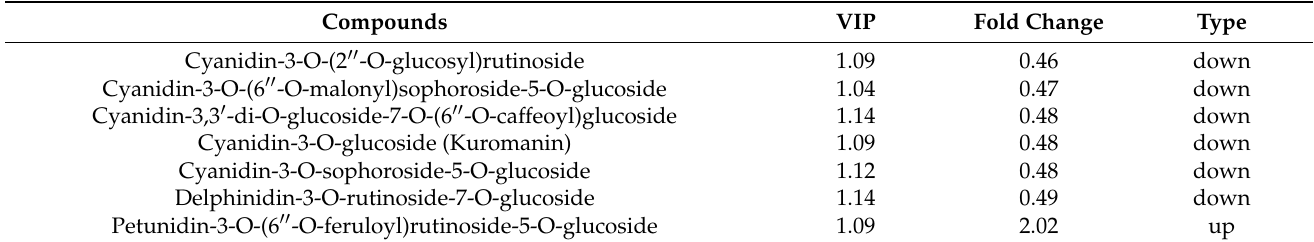
Table 2. Seven anthocyanins changed significantly in PhSK -silenced and control petunia corollas. Compounds VIP Fold Change Type Cyanidin-3-O-(2 (cid:48)(cid:48) -O-glucosyl)rutinoside 1.09 0.46 down